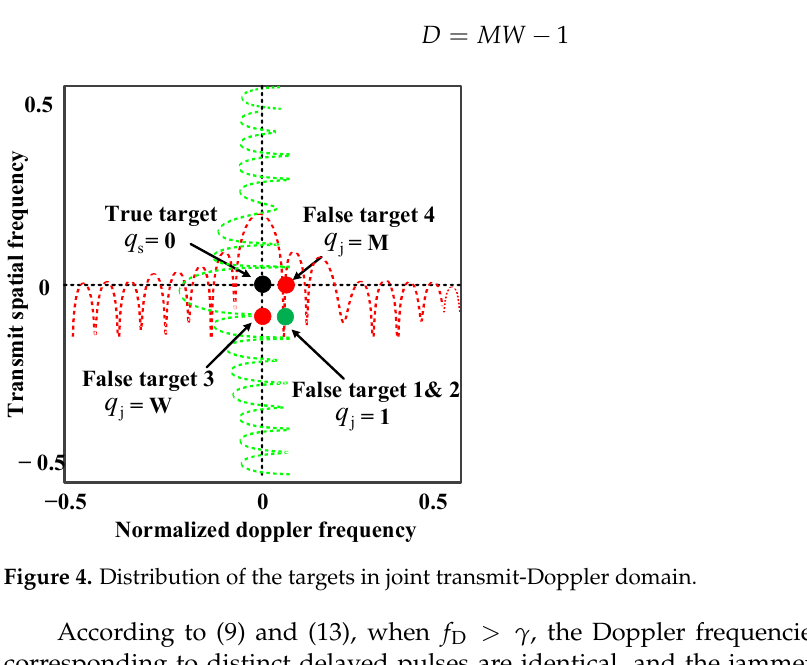
Table 1. Parameters of QPC-FDA-MIMO system.